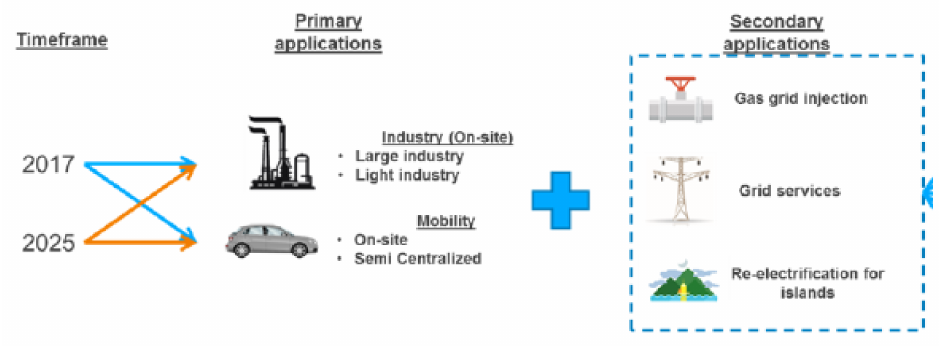
Figure 6. Combinations of basic business cases